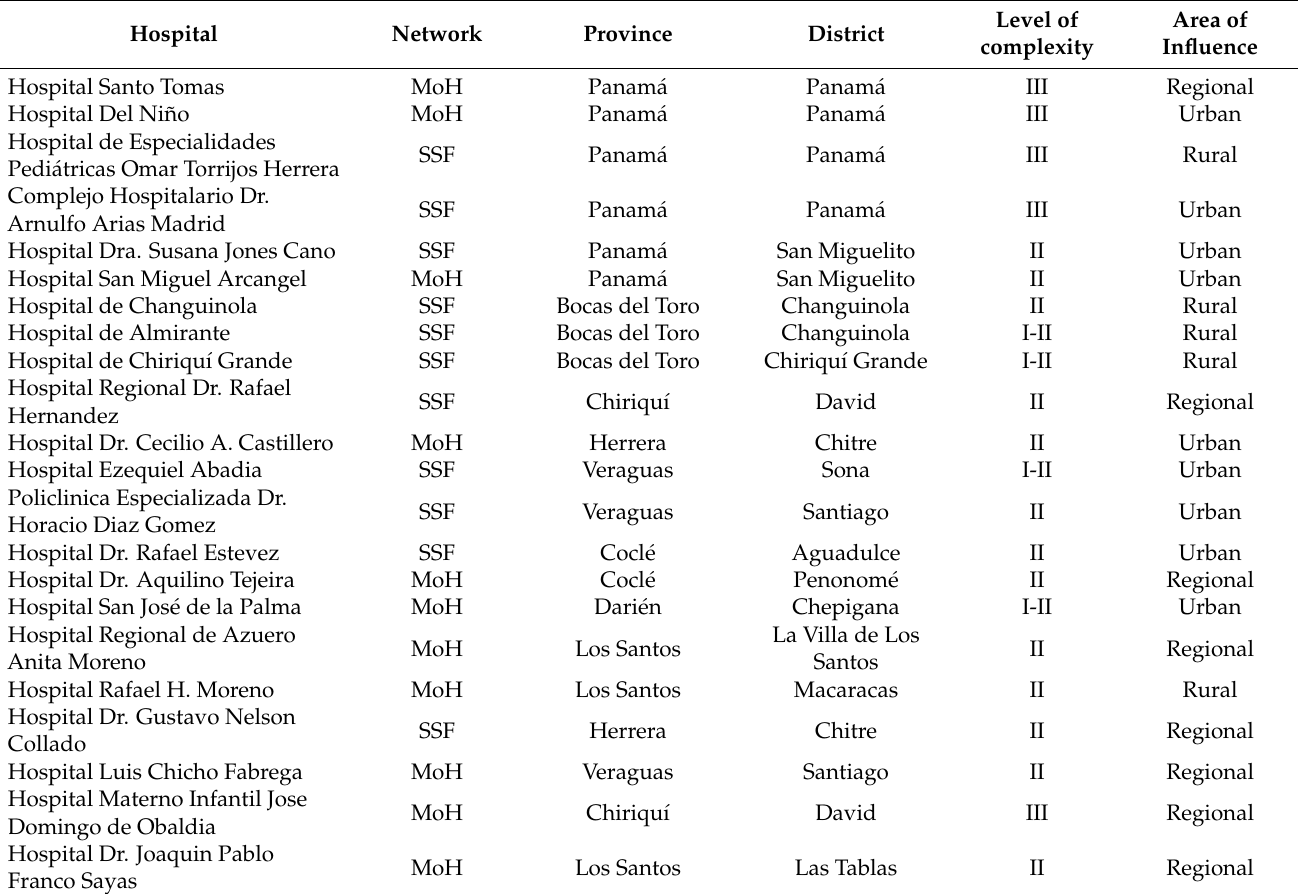
Table A1. Hospitals included in the sample and their main